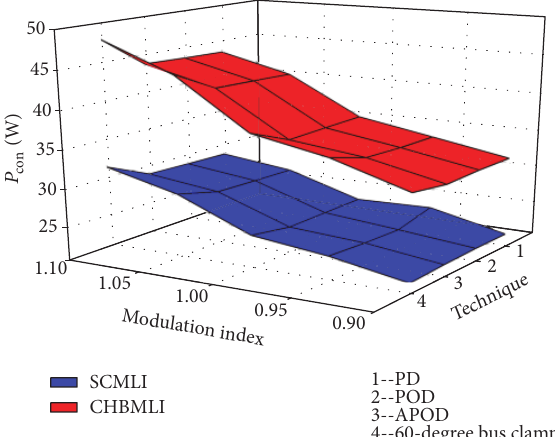
Figure 18: Conduction losses comparisons of the inverters for different